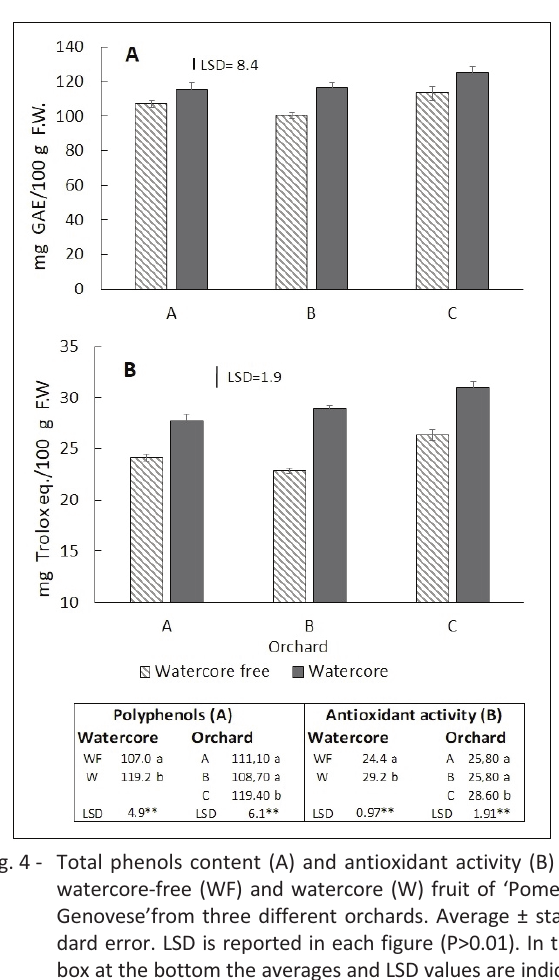
FBK= force at the breaking point; Wr= work; St= stiffness; PK= peak number; ΣPK= sum of peak values. LSD values for the two main factors and their interaction are reported at the bottom (*=P<0.05; **=P<0.01).